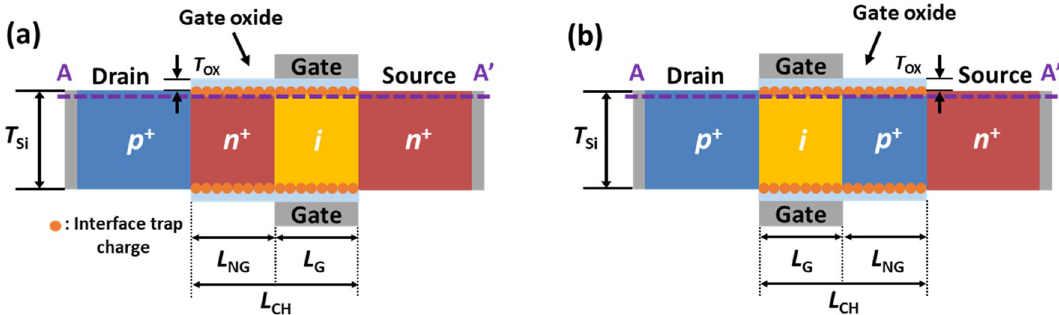
Figure 1. Cross-sectional view of gate-all-around (GAA) ( a ) n - and ( b ) p -FBFETs including interface trap charges between channel region and gate oxide.